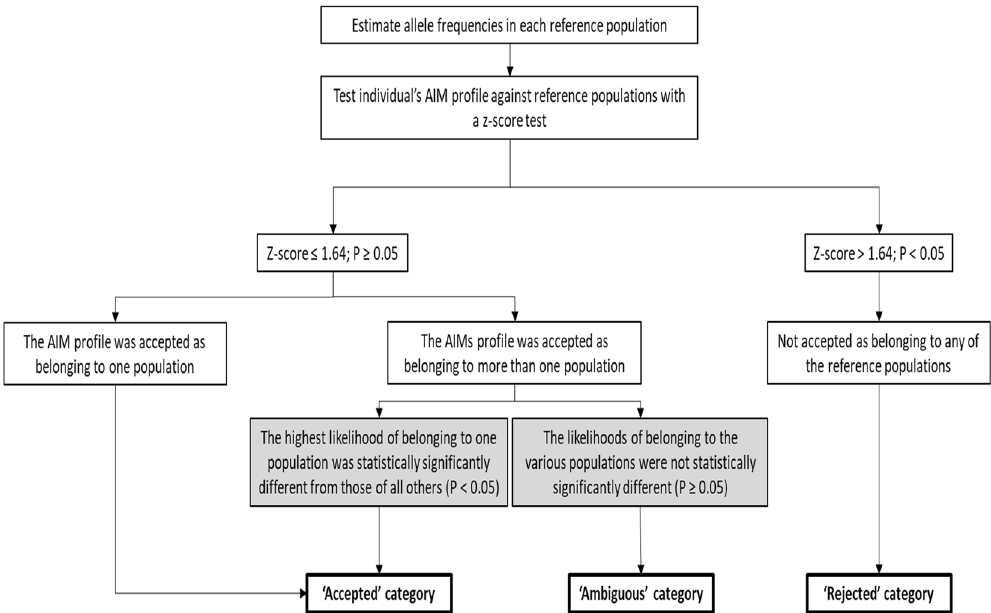
Figure 4. Diagrammatic presentation of the decisions for classification of the results of investigations of ancestry with